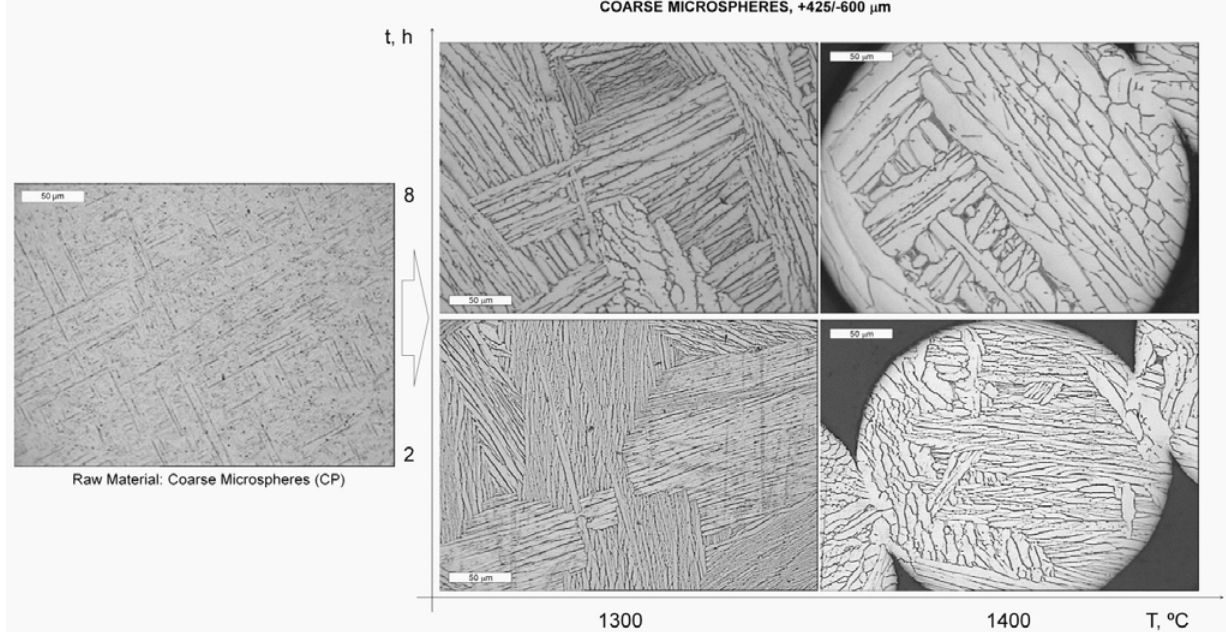
Figure 3. Microstructure of the Ti–6Al–4V microspheres (CP) before and after the sintering process. Etching: Kroll